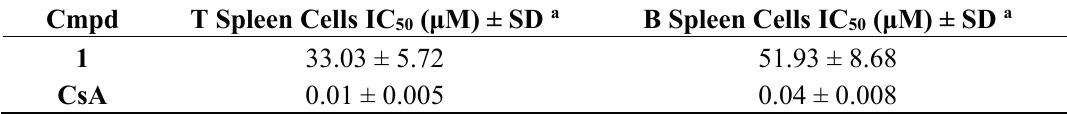
Table 2. Inhibition of spleen cell proliferation by compound 1 and